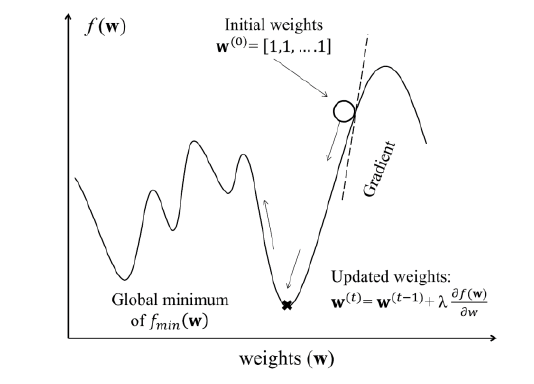
Figure 2: Minimizing the regularized loss function